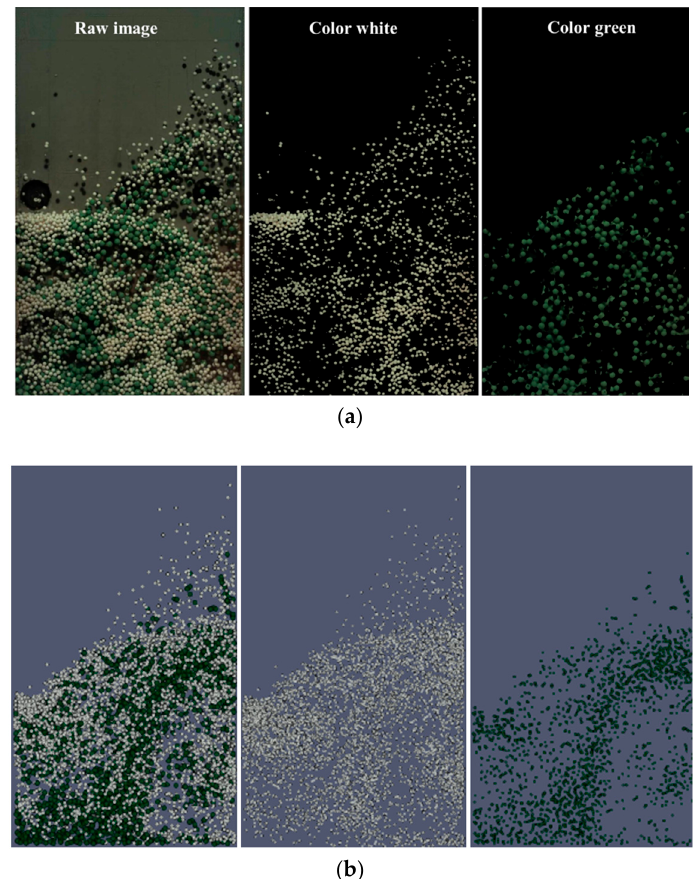
Figure 2. Instantaneous mixing behaviors of particles with binary sizes: ( a ) experiment; ( b ) simulation.